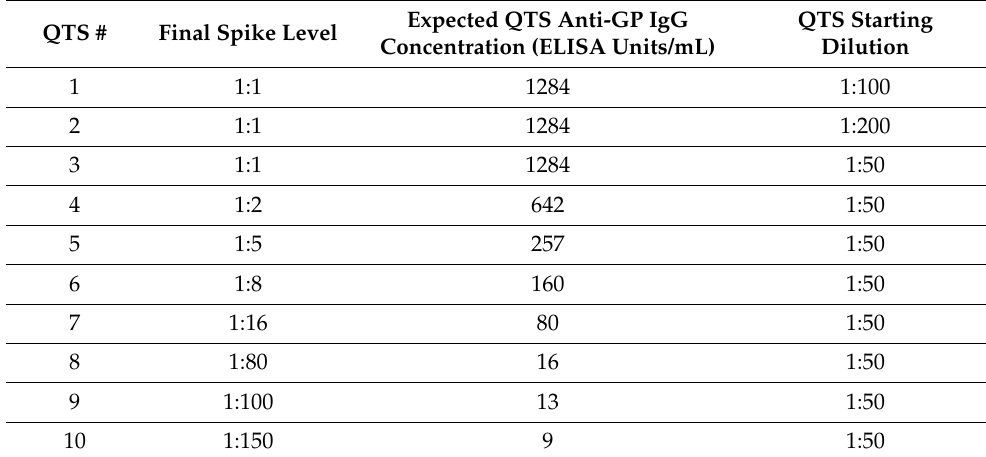
Table 1. Example Dilution Series for One Parent Sample (FLV1001-100023 Day